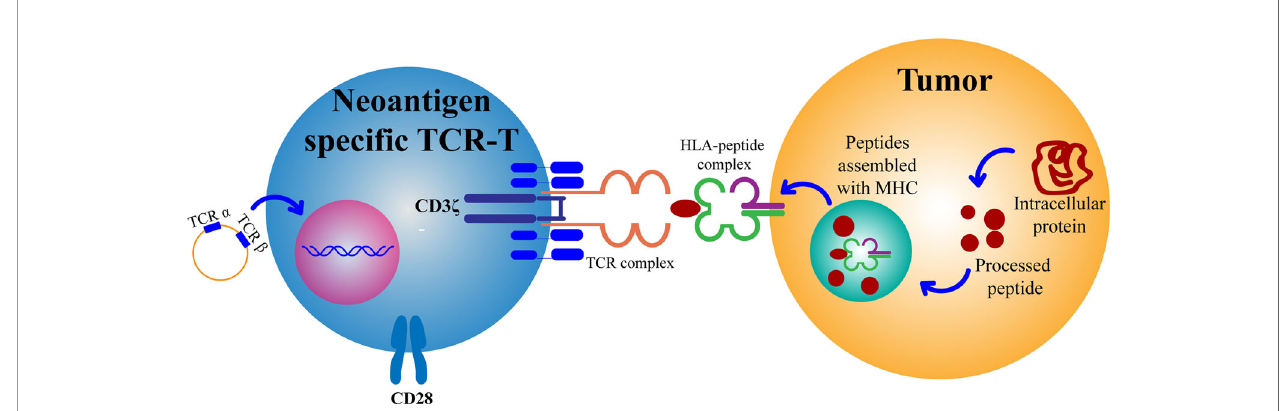
FIGURE 2 | Mature CD8+ T cells with a new antigen-speci fi c TCR gene can recognize antigen targets and thus attack and kill tumor cells. TCR, T cell receptor; HLA, human leukocyte antigen; MHC, major